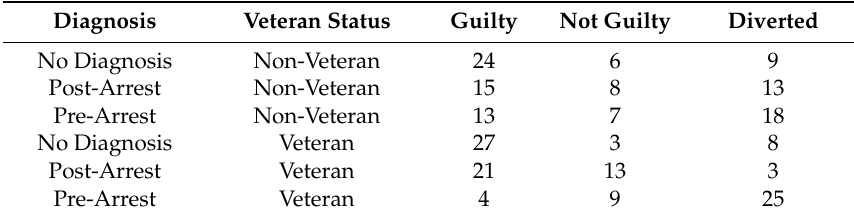
Table 2. Verdict by interaction between diagnosis and veteran